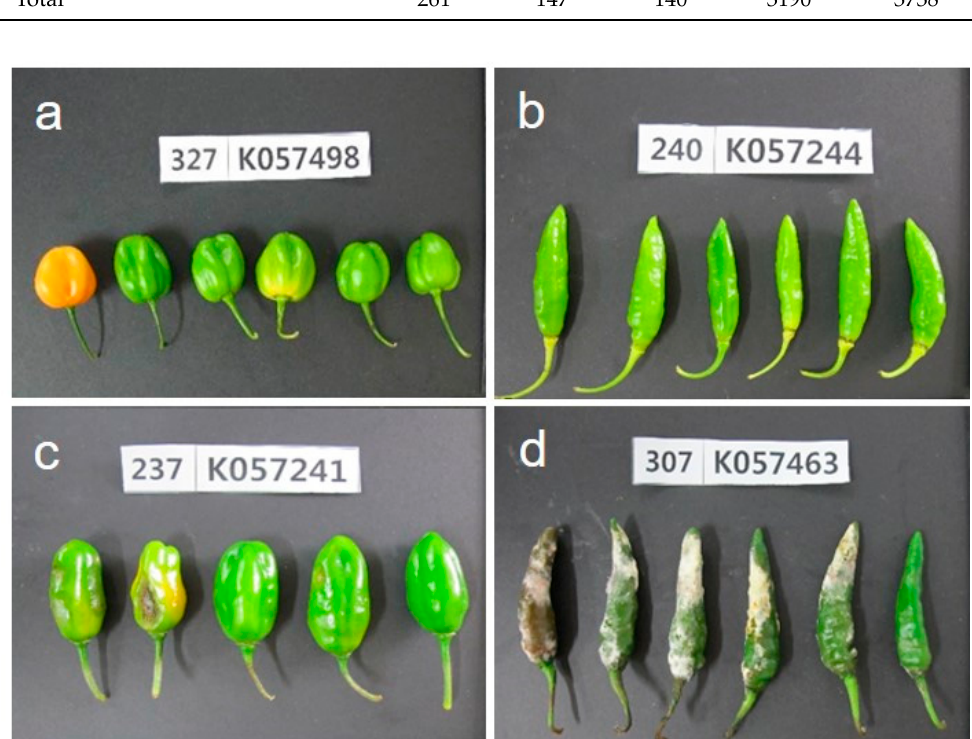
Figure 2. Disease symptoms of fruits after 14 days of non-wounding inoculation with C. acutatum isolate ‘KSCa-1 ′ . ( a ) resistant reaction of C. chinense ; ( b ) resistant reaction of C. baccatum ; ( c ) moderate resistant reaction of C. chinense ; and ( d ) susceptible reaction of C. annuum .